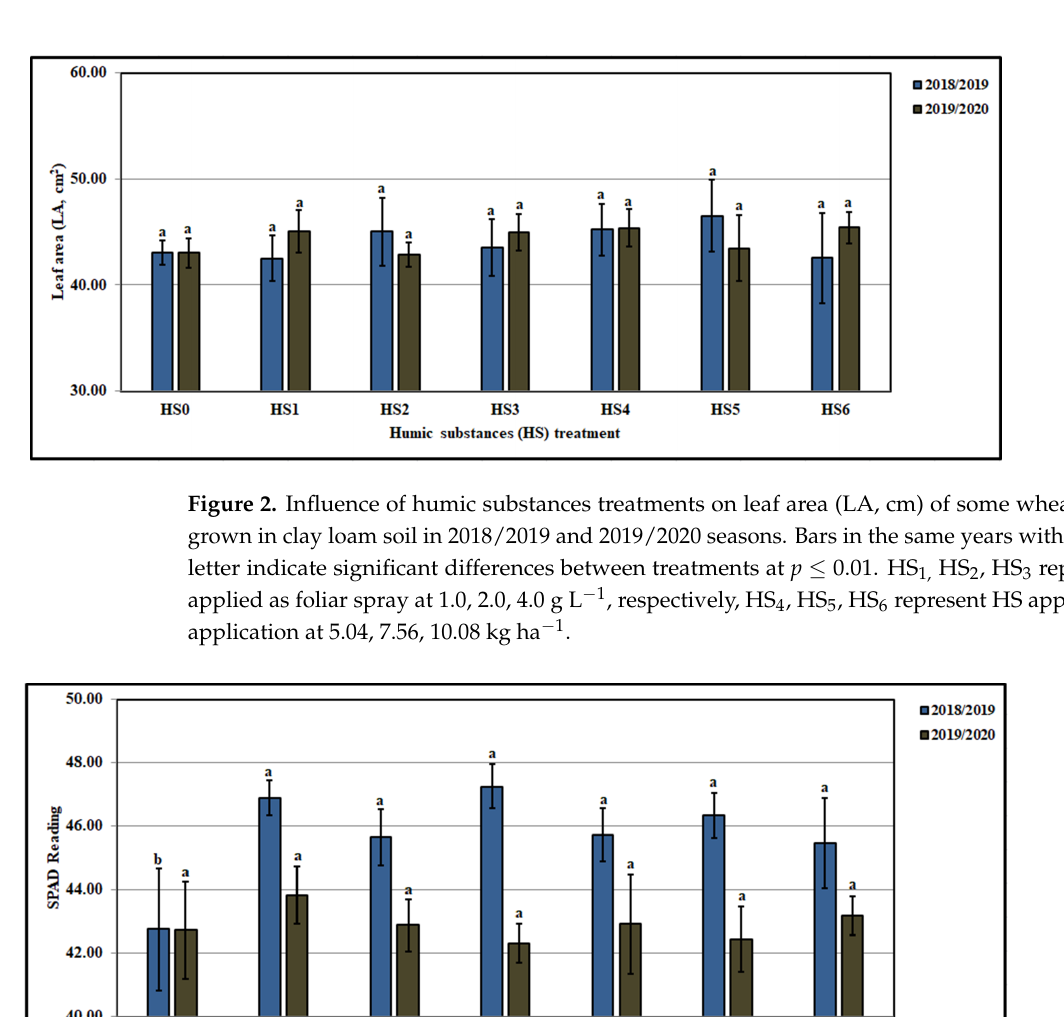
Figure 3. Influence of humic substances treatments on SPAD reading of some wheat varieties grown in clay loam soil in 2018/2019 and 2019/2020 seasons. Bars in the same years with a different letter indicate significant differences between treatments at p ≤ 0.01. HS 1, HS 2 , HS 3 represent HS applied as foliar spray at 1.0, 2.0, 4.0 g L − 1 , respectively, HS 4 , HS 5 , HS 6 represent HS applied as soil application at 5.04, 7.56, 10.08 kg ha − 1 .